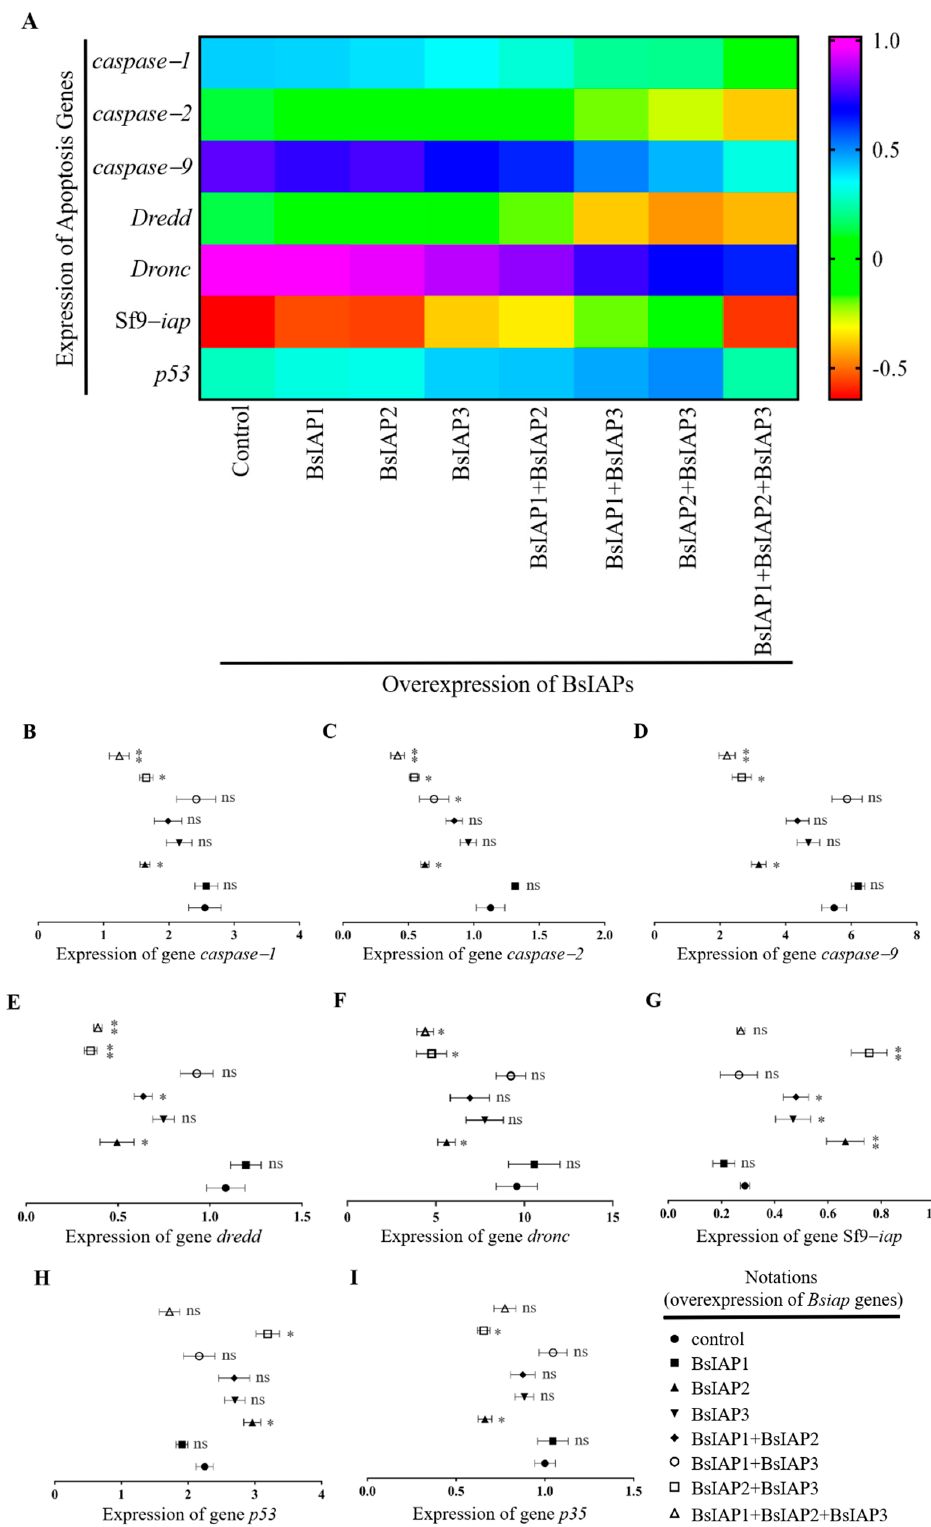
Figure 5. Impact of transient overexpression of BsIAPs on apoptotic gene expression. The expression of apoptosis genes, including the control group, were relative to those of non-transfected insect Sf9 cells. ( A ) Heatmap illustrating the effect of transient overexpressing BsIAPs on apoptotic gene ex- pression. ( B – I ) Detailed results of the effects of transient overexpressing BsIAPs on the expression of casp ase − 1 ( B ), caspase − 2 ( C ), caspase − 9 ( D ), dredd ( E ), dronc ( F ), Sf9 − iap ( G ), and p53 ( H ). * p < 0.05, ** p <